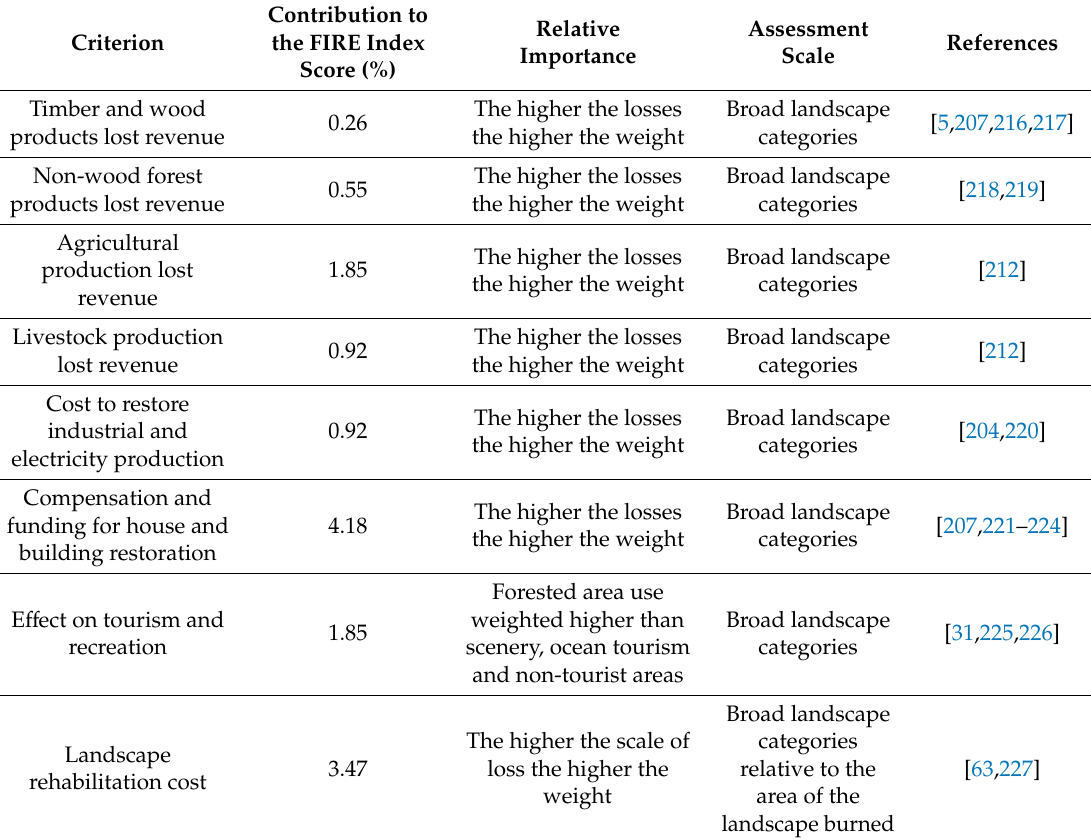
Table 7. Relative importance, assessment scale and relevant literature for each criterion for the economic losses fire e ff ects